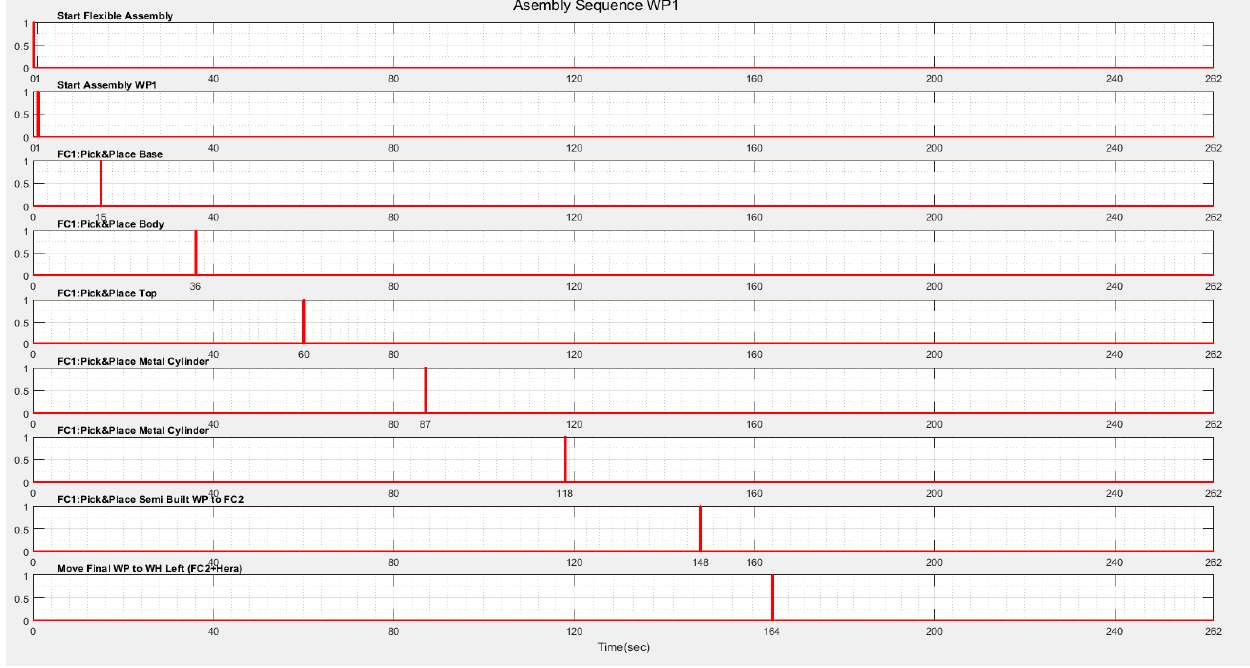
Figure 19. Real-time monitoring signals corresponding to assembly operations of WP1.